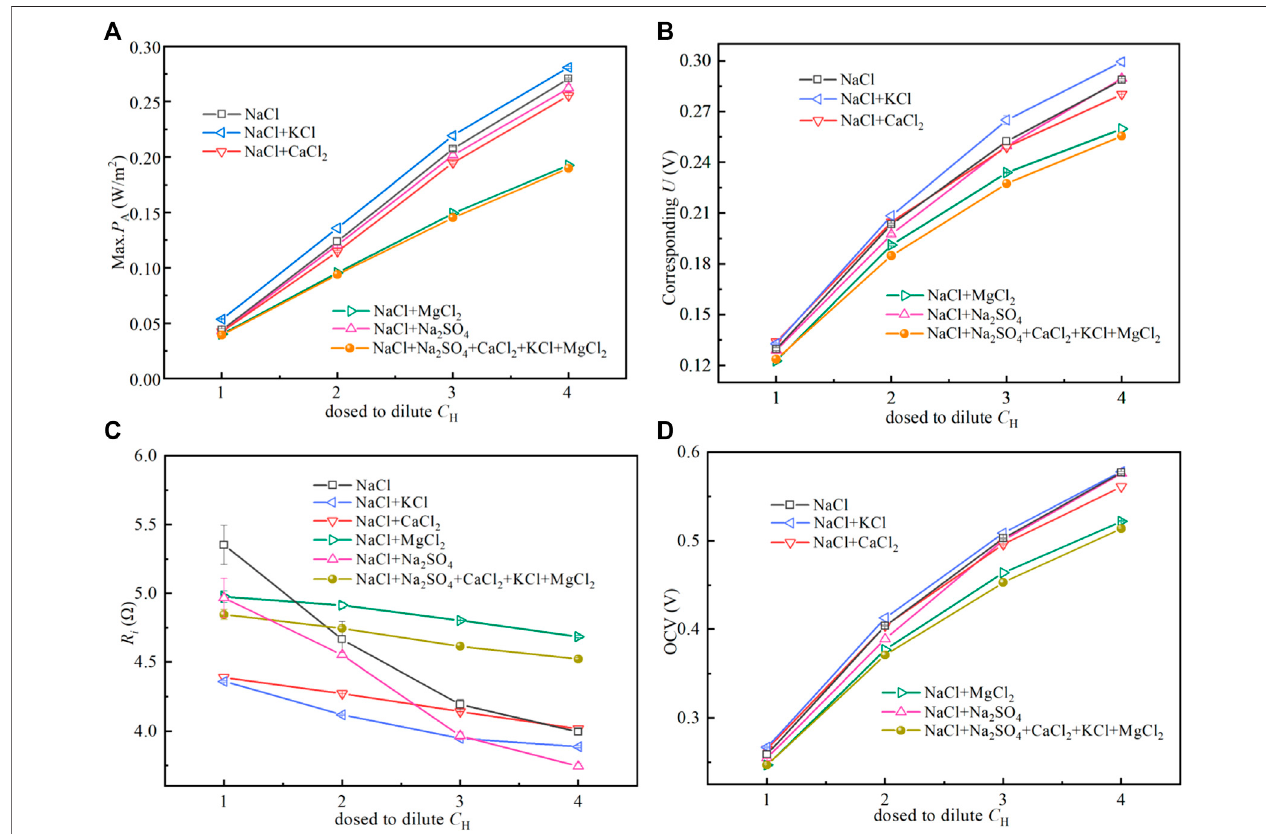
FIGURE 6 | Performance variation of the RED stack with the concentration of the brine (CH). The experiment was carried out at t = 14 ° C, Φ = 50 ml/min. In the experiment,oneorallof0.270 mol/LMgCl